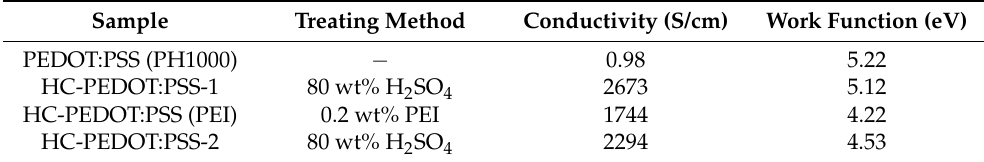
Table 1. Statistics of conductivity and work function variations of PEDOT:PSS (PH1000) under dif- ferent treating conditions.